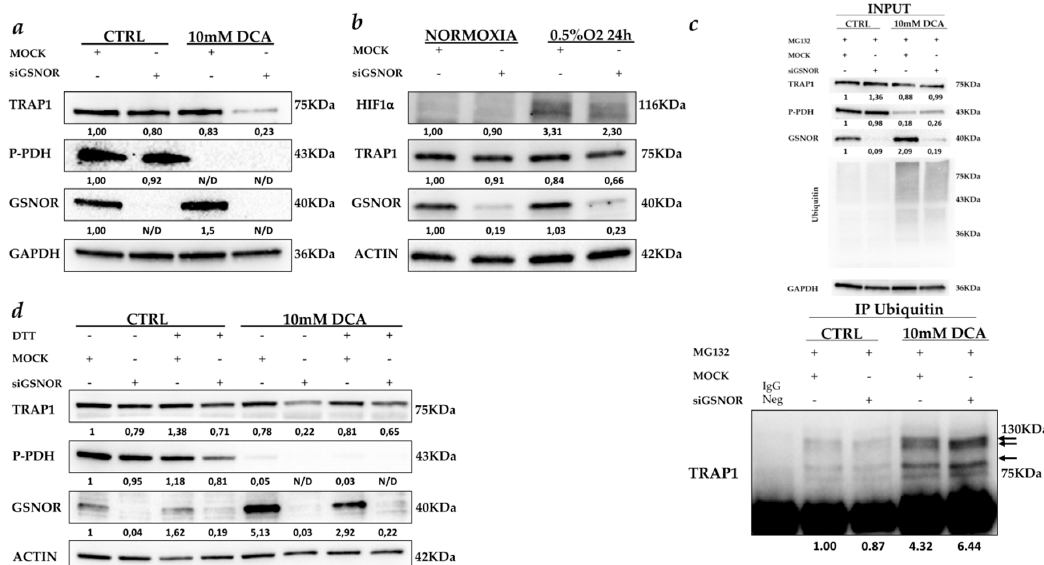
Figure 5. GSNOR protects TRAP1 from S-nitrosylation. ( a ) TRAP1, phospho-pyruvate dehydrogenase (P-PDH) and GSNOR immunoblot analysis in Mock- and GSNOR-silenced HCT116 cells cultured in the presence and the absence of 10 mM dichloroacetate (DCA) for 24 h. ( b ) TRAP1, Hypoxia-inducible factor 1-alpha (HIF1 α ) and GSNOR immunoblot analysis in Mock- and GSNOR-silenced HCT116 cells cultured in normal conditions (normoxia) or in presence of 0.5% O 2 (hypoxia) for 24 h. ( c ) TRAP1 immunoblot analysis of anti-ubiquitin immunoprecipitates from Mock- and GSNOR-silenced HCT116 cells cultured in the presence and the absence of 10 mM DCA for 24 h. Cell lines were incubated with 10 µ M Mg132 for 4 h before cell harvesting. Arrows indicate bands of TRAP1 mono / polyubiquitination. Input: TRAP1, P-PDH GSNOR and ubiquitin immunoblot analysis in Mock- and GSNOR-silenced HCT116 cells cultured as indicated in c. ( d ) TRAP1, P-PDH, and GSNOR immunoblot analysis in Mock- and GSNOR-silenced HCT116 cells cultured in the presence and the absence of 10 mM DCA for 24 h and further incubated with 0.5 mM dithiothreitol (DTT) for 3 h before cell harvesting. N / D, not